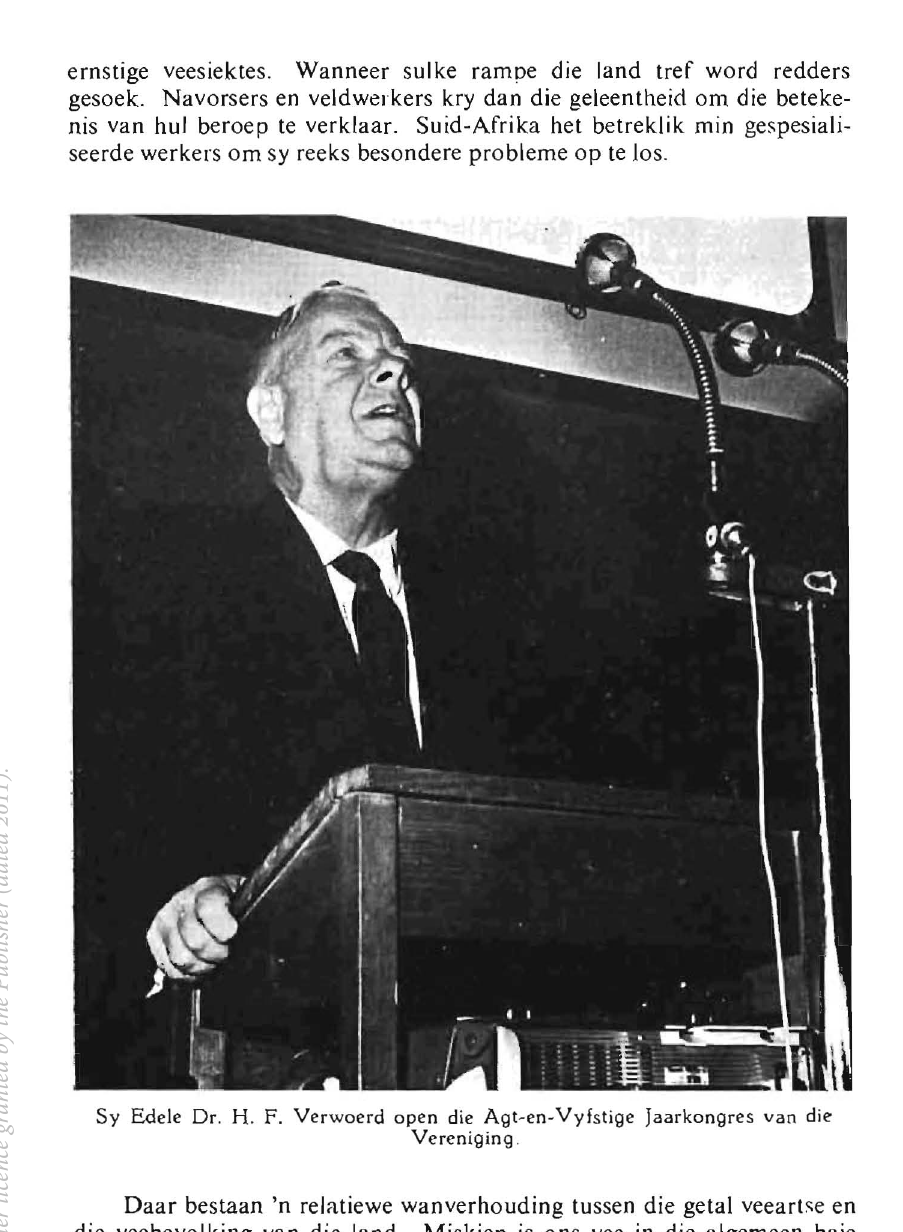
ernstige veesiektes. Wanneer sulke rampe die land tref word redders gesoek. Navorsers en veldwelkers kry dan die geleentheid om die beteke nis van hul beroep te verklaar. Suid-Afrika het betreklik min gespesiali seerde werkers om sy reeks besondere probleme op te los.